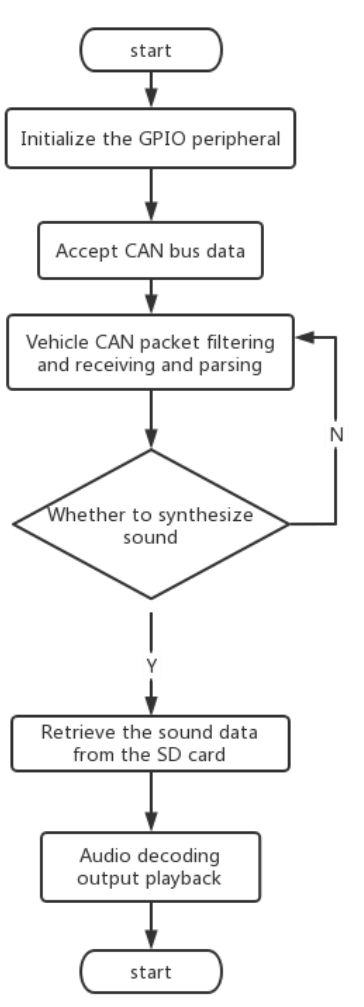
Figure 18. Sound simulation system software execution flow.